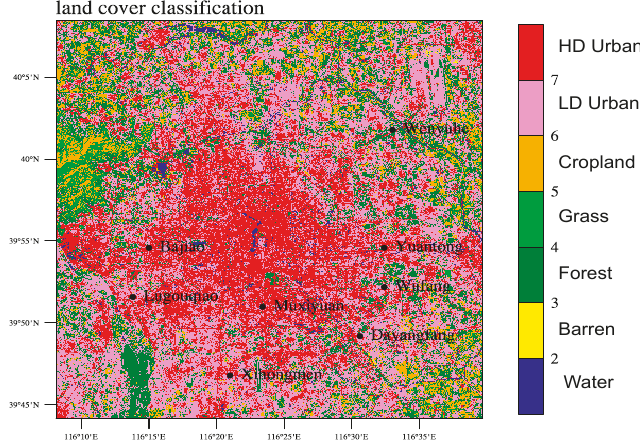
Figure 1. Land cover classification of Beijing urban area and the locations of eight road sites.